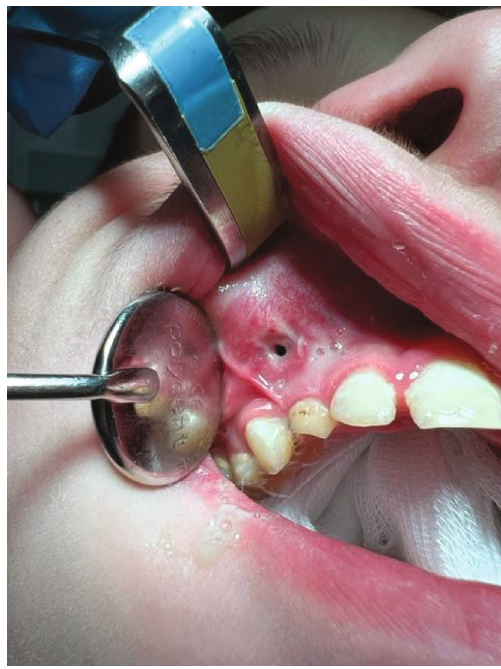
Figure 3: Tooth 53 is removed and oroantral fi stula is